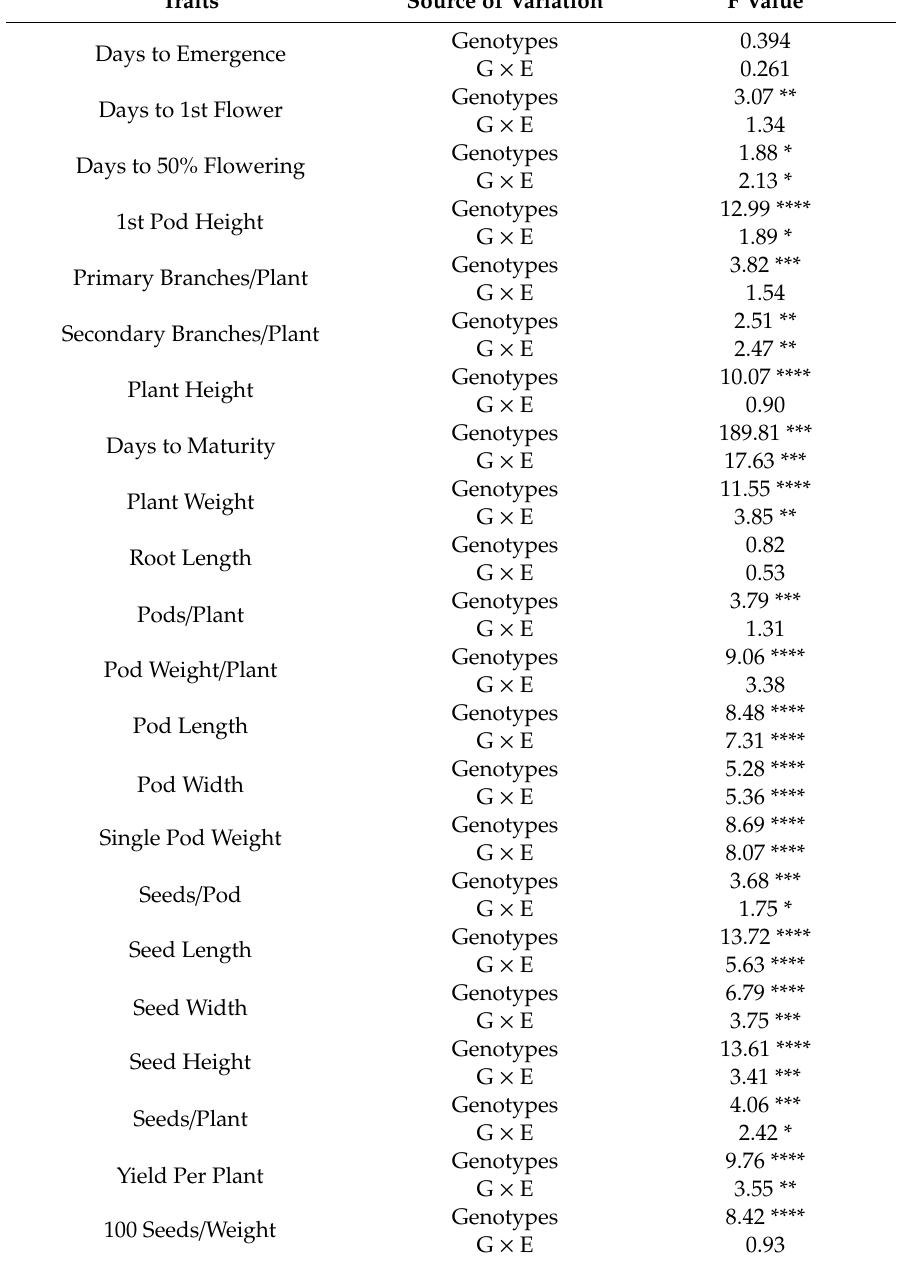
Table 1. Summary of analysis of variance (ANOVA) for di ff erent traits of Turkish common bean